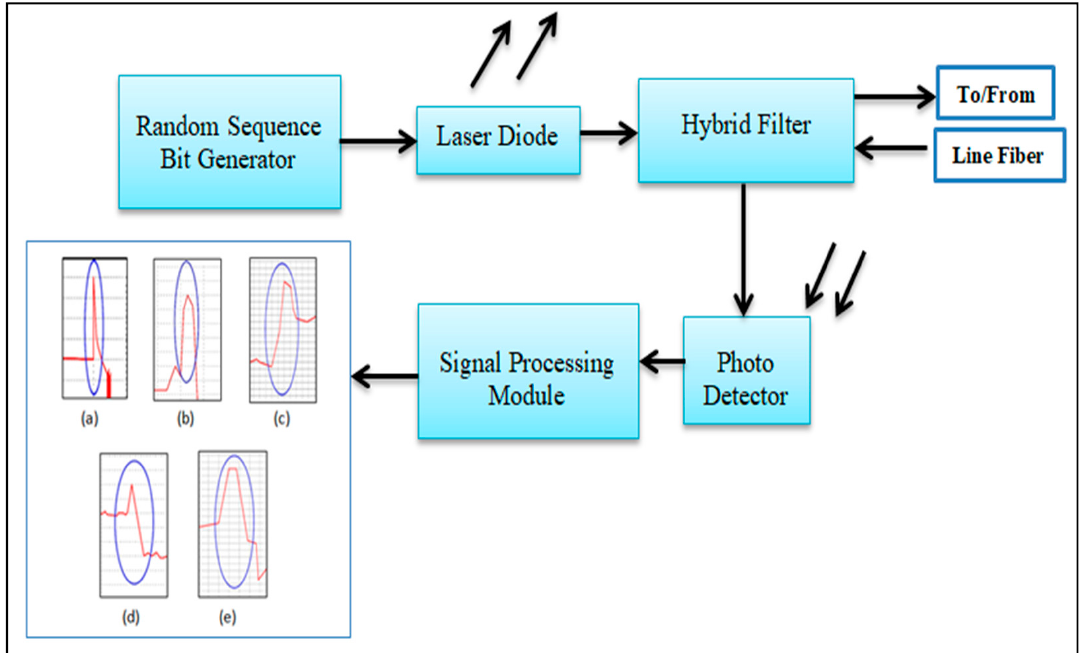
Figure 2. The FPMT technique detection circuit diagram.